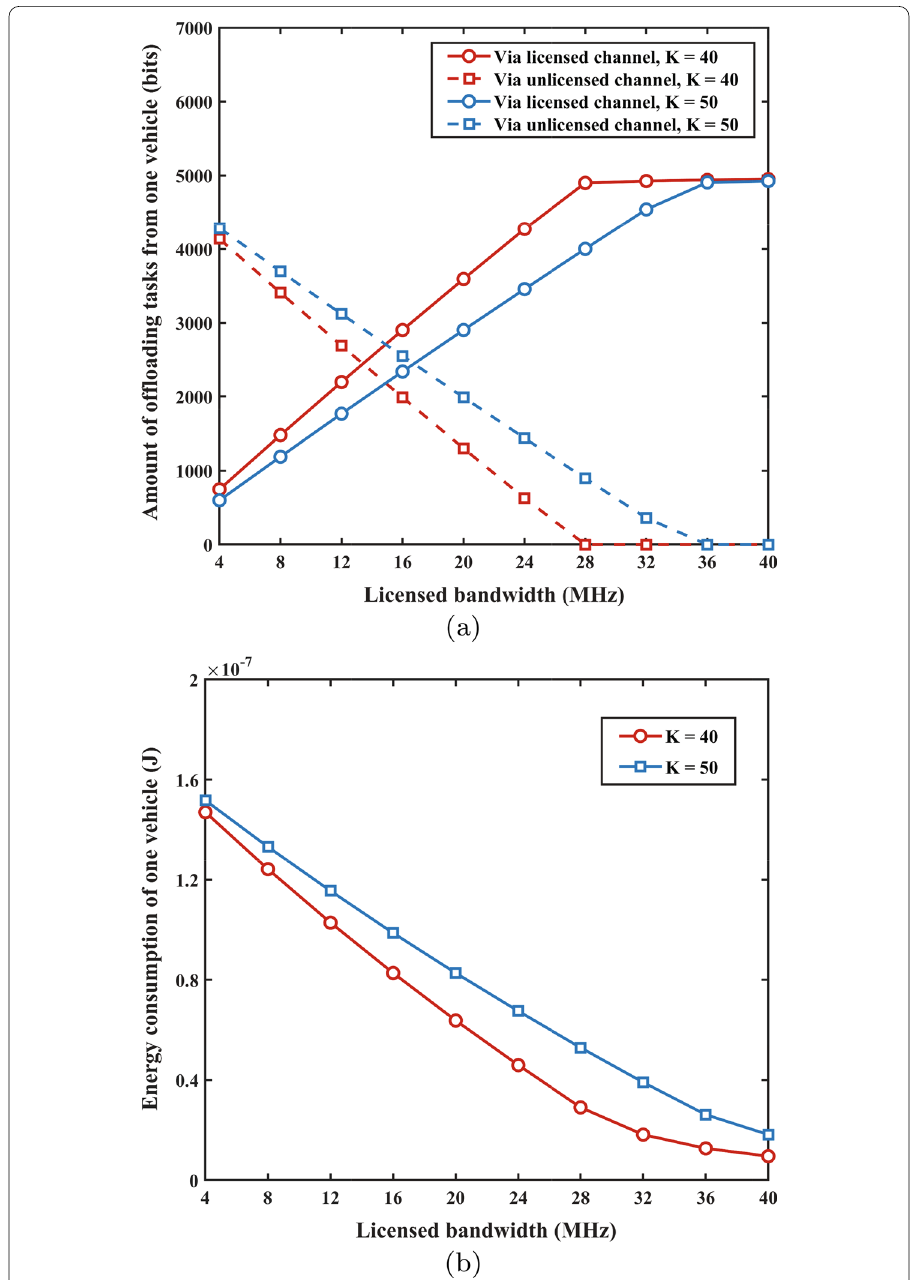
Fig. 4 The impact of licensed spectrum bandwidth, S k task offloading from one vehicle; b the effect on energy consumption of one